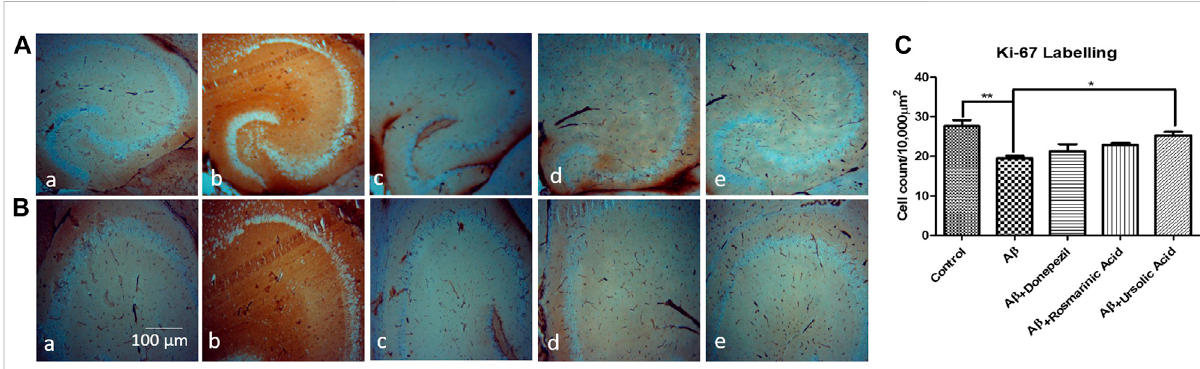
FIGURE 3 Neuronspeci fi cKi-67Labellingofmicehippocampaltissue:(a)Control(b)A β 1 – 42 -treatedgroup(c)A β 1 – 42 +donepezil-treatedgroup(d)A β 1 – 42 +RA-treatedgroup(e)A β 1 – 42 +UA-treatedgroupsatmagni fi cation (A) 4X (B) 10X. (C) Graphshowingcellcount/10000 µm 2 ofKi-67labelledcellsin mice hippocampus in experimental groups respectively. Signi fi cance was analyzed by One-way ANOVA followed by Bonferroni comparison test (mean ± SEM) using Graphpad Prism. * p < 0.05 ** p < 0.01.